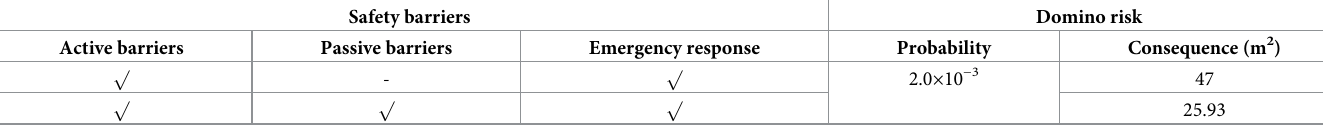
Table 24. Domino risk considering different types of safety